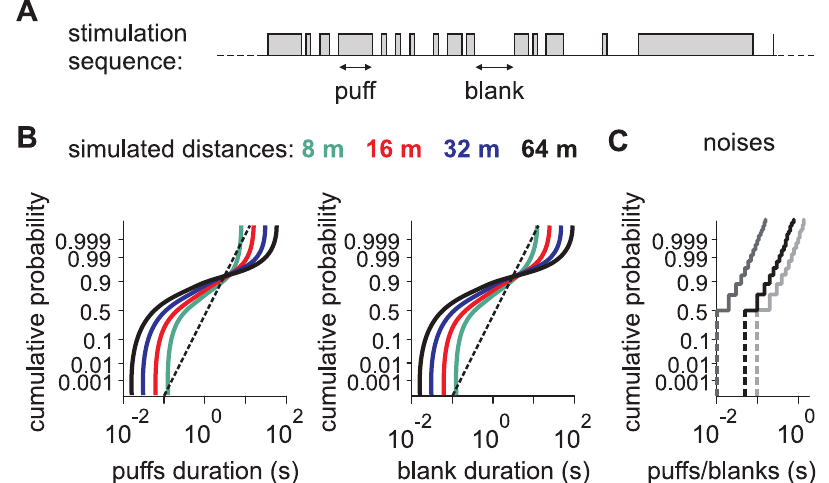
Fig 6. Turbulent stimuli have more events with extremeduration at long simulated distances. (A) Exampleof a binary turbulent stimulationsequence.Puffs and blanks were definedas the presence and absenceof pheromone displayedto the antenna.(B) Normal ProbabilityPlot of the duration of puffs and blanks of turbulent stimuli. Colors code for the distanceto the source. In Normal ProbabilityPlots, any Gaussiandistributionwouldappearas a straight line as shown (dotted line). In comparison turbulent stimuli have characteristic shapeof long tail distributionswith an excess of large and small values, and the excess increaseswith the distancefrom the source. (C) Normal ProbabilityPlot for binary white-noises with different correlationtime (dark grey, 10 ms; black, 50 ms; light grey, 100 ms). Duration of puffs and blanks have the same exponential distributionin white-noise, which by definitionis not